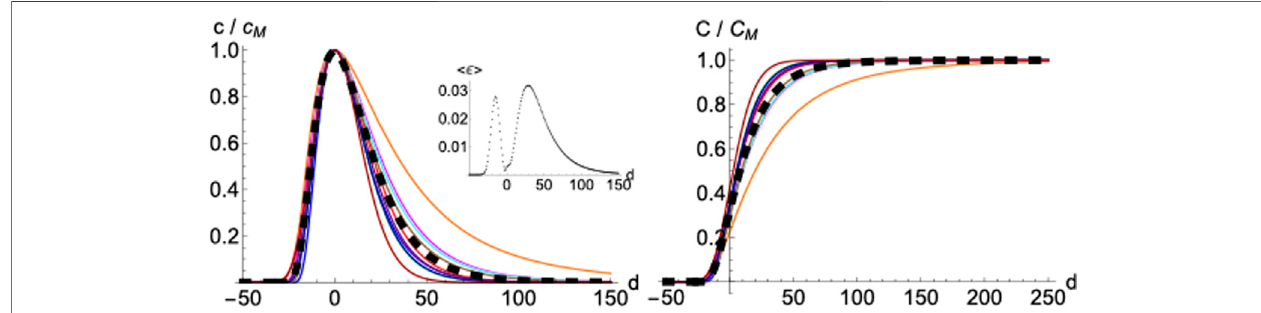
FIGURE 6 | Averaged pro fi le. Daily c ( t ) (left panel) and accumulated C ( t ) (cid:2) r ( t ) cases (right panel) for ten different countries, normalized to its maximum value and displaced rigidly in time so C ″ ( t ) (cid:2) c ′ ( t ) (cid:2) 0 the same day. Color codes are: (1) Spain (blue), (2) Germany (red), (3) France (green), (4) United States (orange), (5) Italy (magenta), (6) Great Britain (cyan), (7) Switzerland (purple), (8) Denmark (brown), (9) Austria (darker blue) (10) Finland (darker red). The black thick dashed line gives the average over the ten countries, with μ (cid:2) 3 . 53, σ (cid:2) 0 . 56.